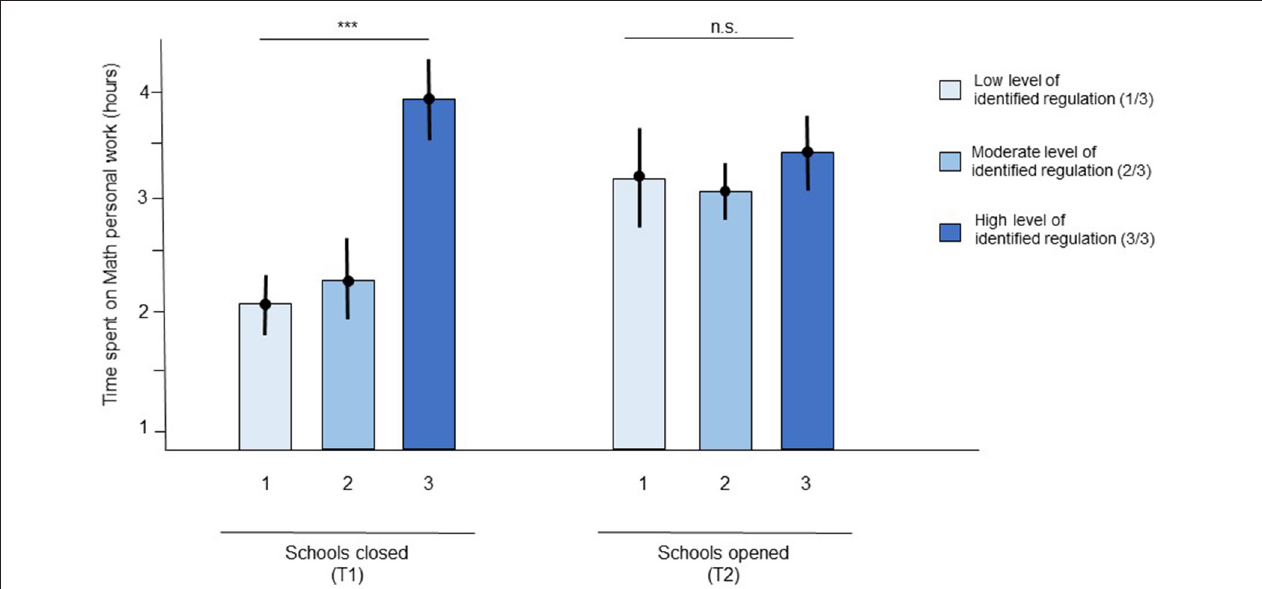
FIGURE 1 | Time spent on personal work in Math was influenced by identified regulation only during the first lockdown with school closed. Means are represented by a dot and standard errors of the mean by the errors bars. *** indicates that the main effect of identified was significant with p < 0.01 during the lockdown with schools closed. n.s. indicates that the main effect of identified regulation was non-significant ( p > 0.05) during the lockdown with schools opened.